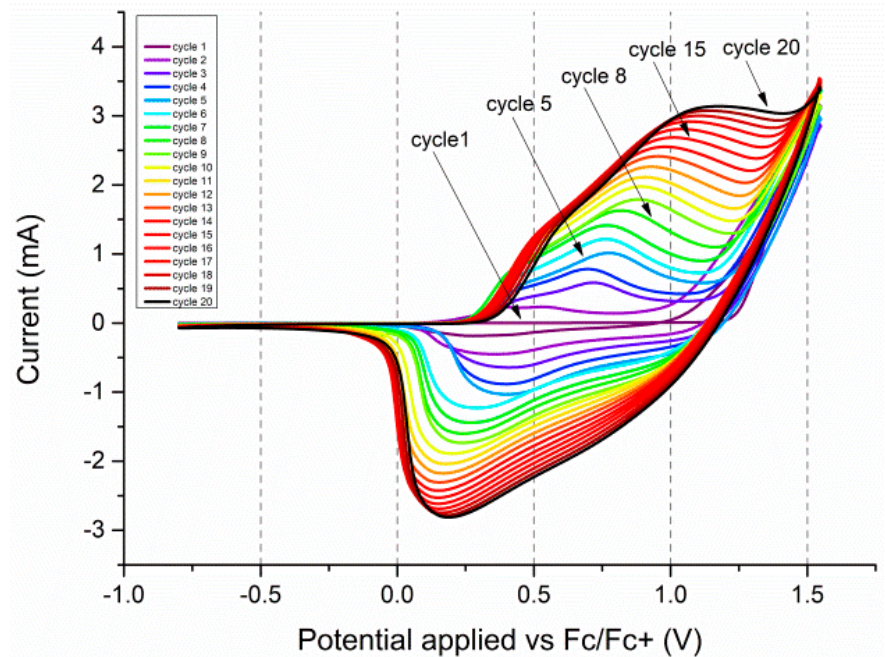
Figure A1. CV recorded during the electrochemical polymerisation of 20 mM HT in 0.1 M tetrabutylammonium tetrafluoroborate.